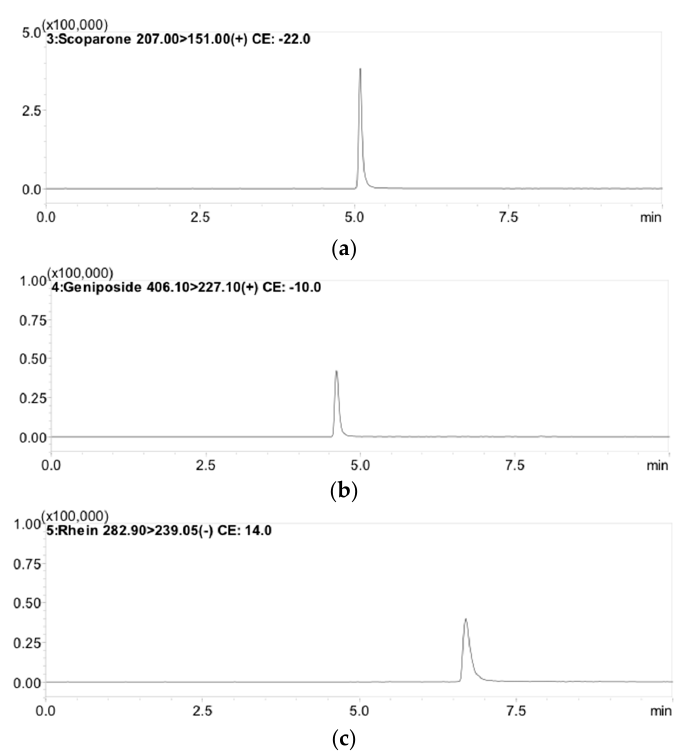
Figure 2. Typical MRM chromatograms of: ( a ) scoparone (RT: 5.3 min); ( b ) geniposide (RT: 4.7 min); and ( c ) rhein (RT: 6.9 min).